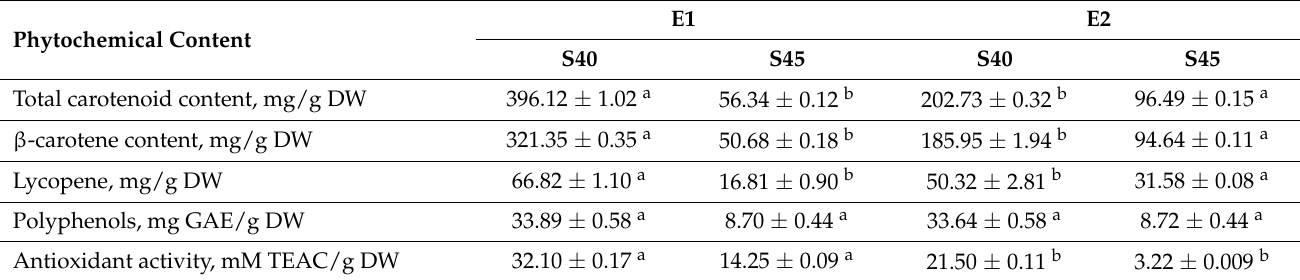
Table 1. Phytochemical composition of SFE-CO 2 SBP oil